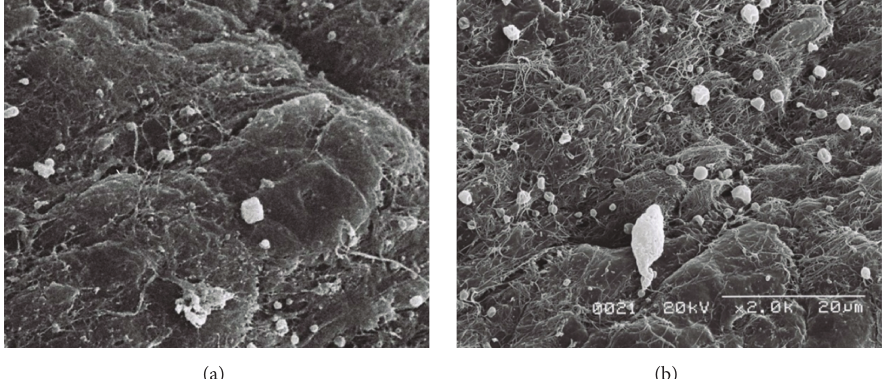
Figure 9: The left eye of Rabbit Number Three treated with ICG dissolved for only 30 seconds had larger white granules (b) compared with the right eye, which was treated with ICG, that was vortexed for a longer time